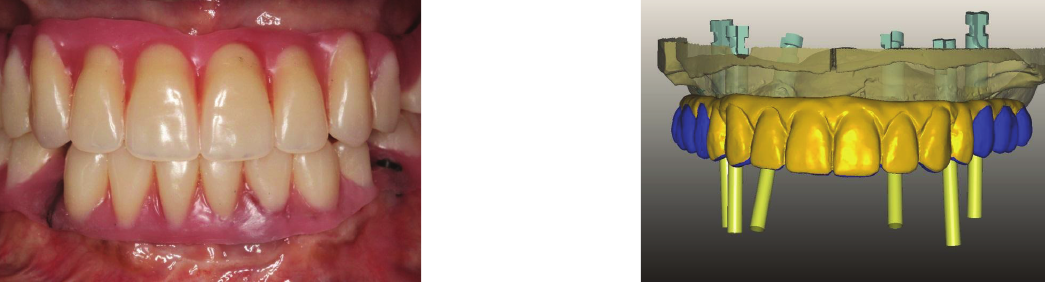
Figure 2: Intraoral frontal view of artificial teeth arrangement.